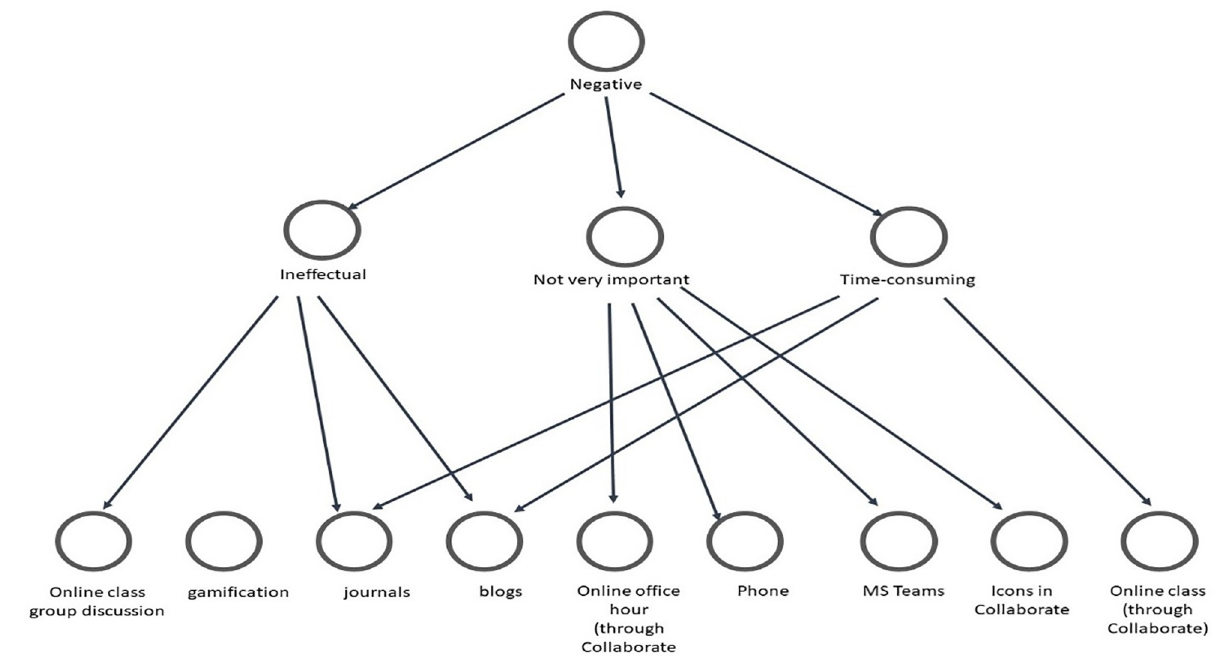
Fig 9. Codes associated with negative themes regarding tools for consideration in the future.